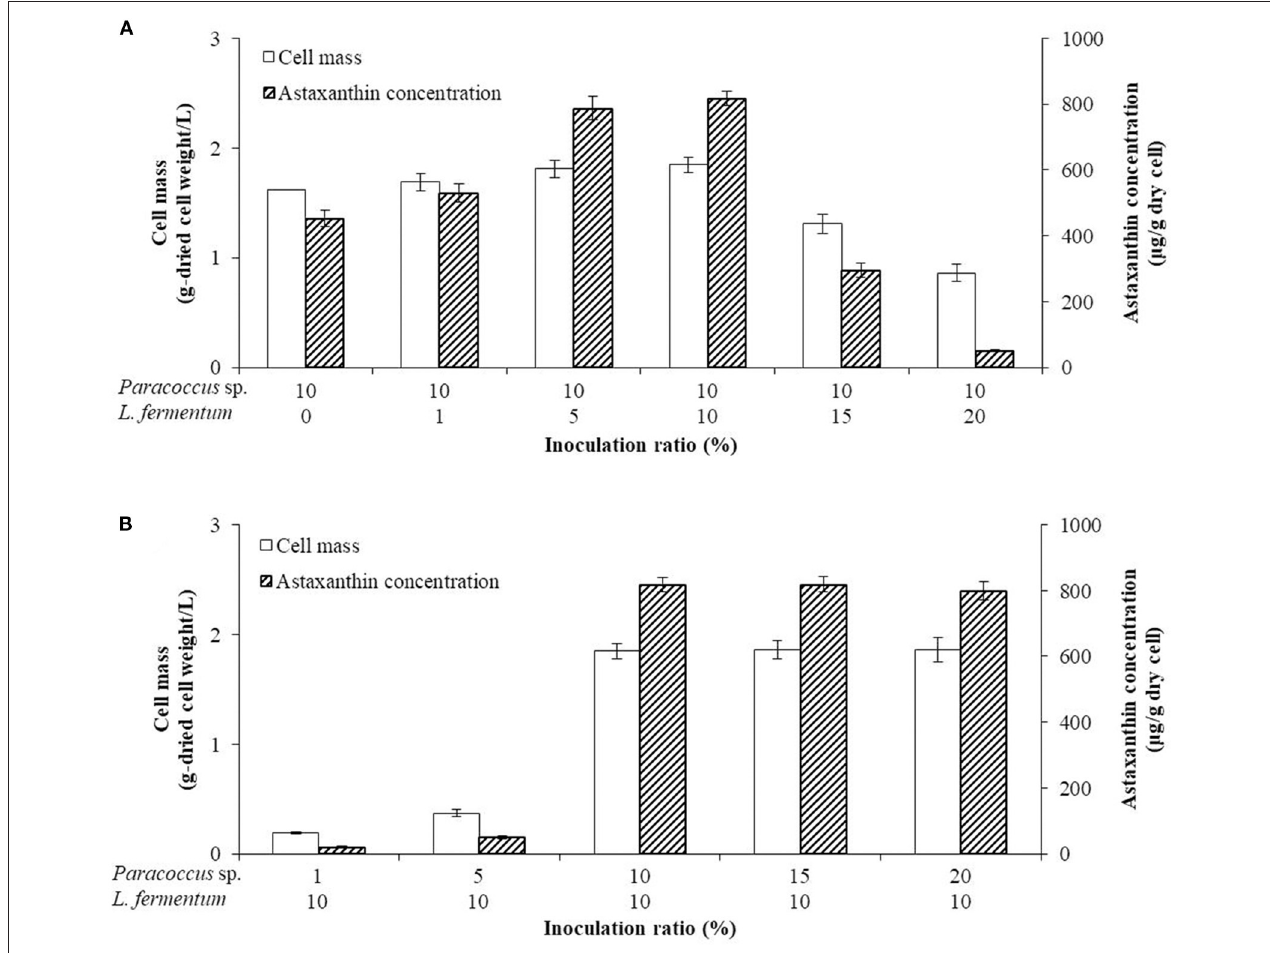
FIGURE 4 | Comparison of cells and astaxanthin concentrations by the ratio of inoculation. The optimization of the inoculation ratio of the two strain cultures was confirmed by (A) fixing the inoculation of Paracoccus haeundaensis at 10% and varying the inoculation volume of Lactobacillus fermentum ; and (B) fixing the inoculation of L. fermentum at 10% and varying the inoculation volume of P. haeundaensis